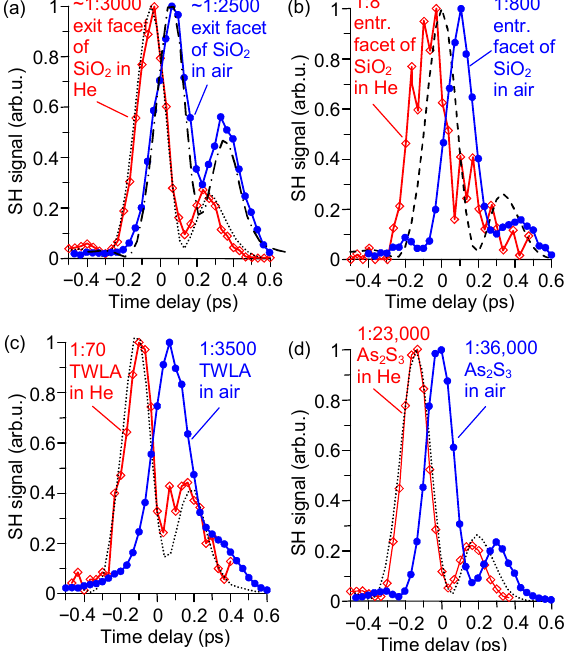
Figure 3. Normalized SH signal as a function of time delay between optical and terahertz pulses for ( a , b ) Si, ( c ) TWLA, and ( d ) As 2 S 3 . Detections are ( a ) from the exit facet of SiO 2 , and ( b , c ) from the entrance facet of the sample. Red diamonds—measurements in air; blue filled circles—measurements in helium. Normalized coefficients are given for the corresponding curves. Dashed curve in ( b ) is normalized terahertz electric field squared; dotted and dash-dotted curves in ( a , c , d ) correspond to theoretical modeling (see text).